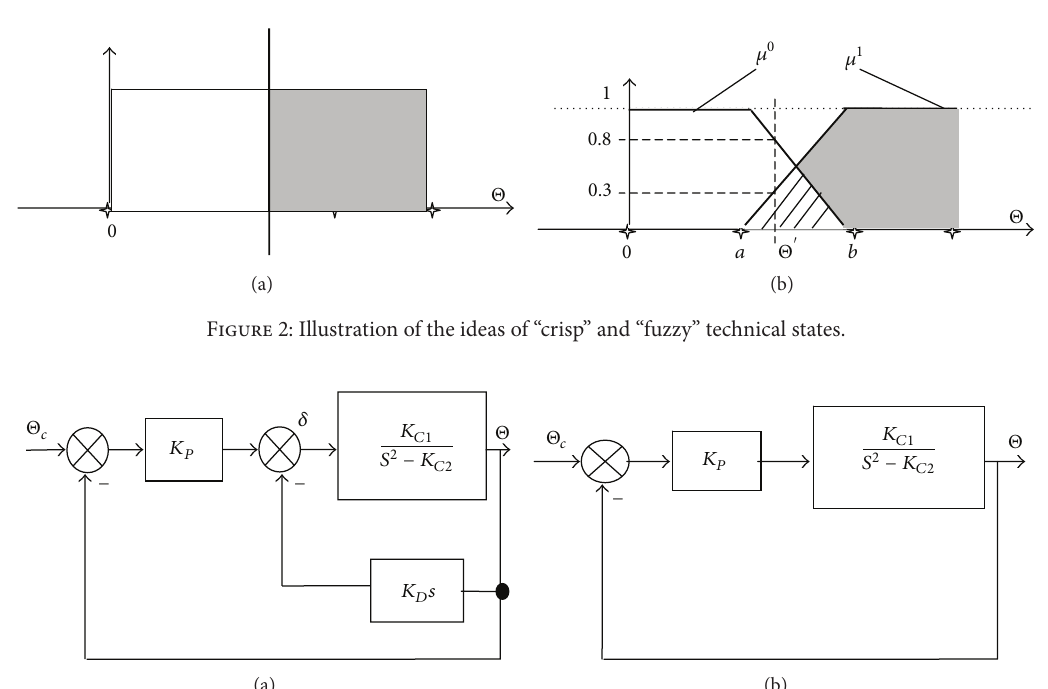
technical state, whereas the observer is adjusted for the 𝑗 th technical state. In this case, parameters {𝑎 𝑖 , 𝑏 𝑖 | 𝑖 = 0, 𝑁}